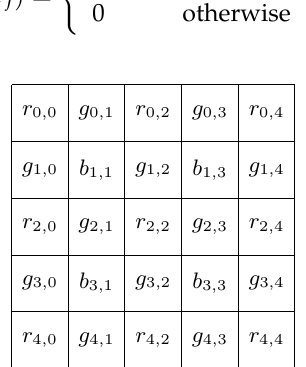
Figure 3. Bayer Filter